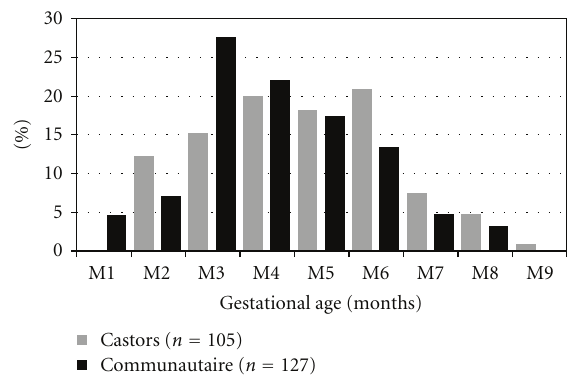
Figure 1: First antenatal clinic attendance according to gestational age, September 2009, Central African Republic.